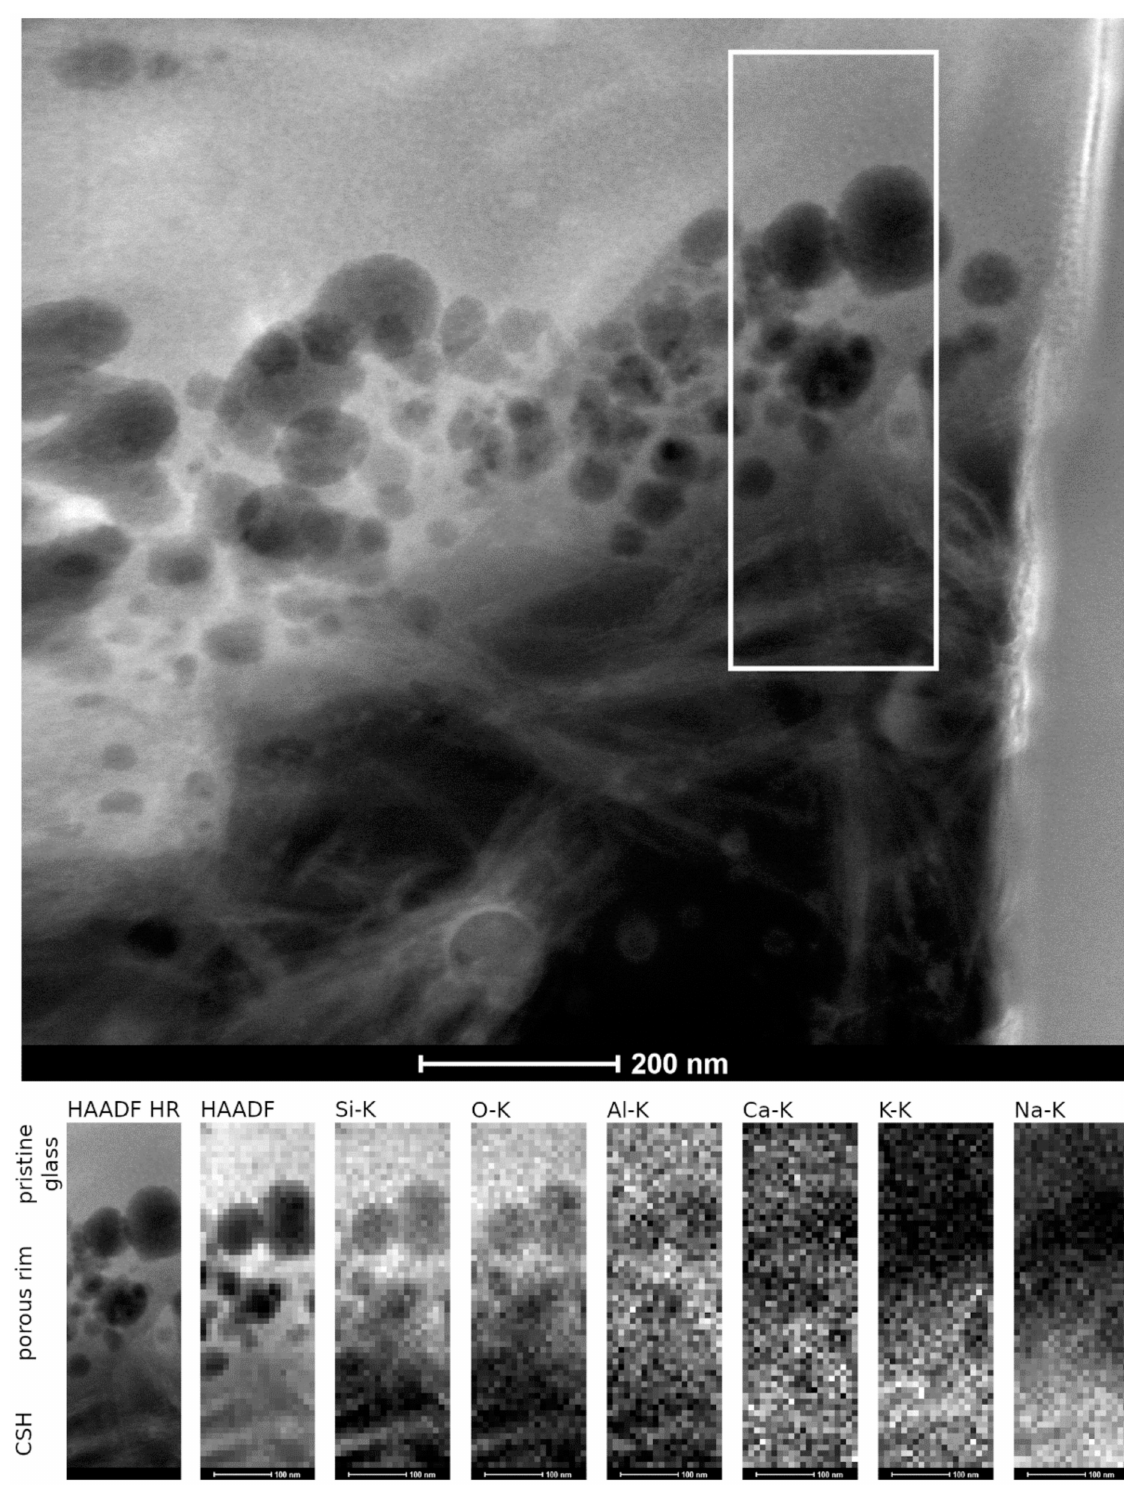
Figure 10. STEM EDS mapping of the porous altered layer–secondary phases interface as observed in the HAADF STEM image. Elemental mappings of Si-, O-, Al-, Ca-, K-, and N- K